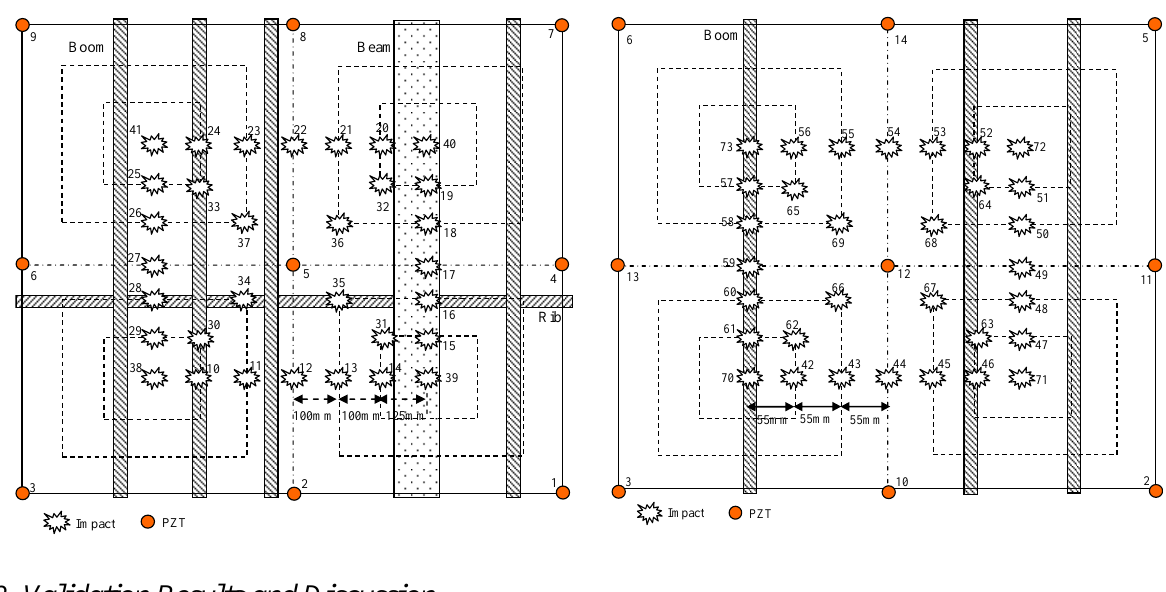
Figure 15. Illustration of impact numbers and positions in the validation experiment. ( left ) Impacts applied in impact monitoring region 1. ( right ) Impacts applied in impact monitoring region